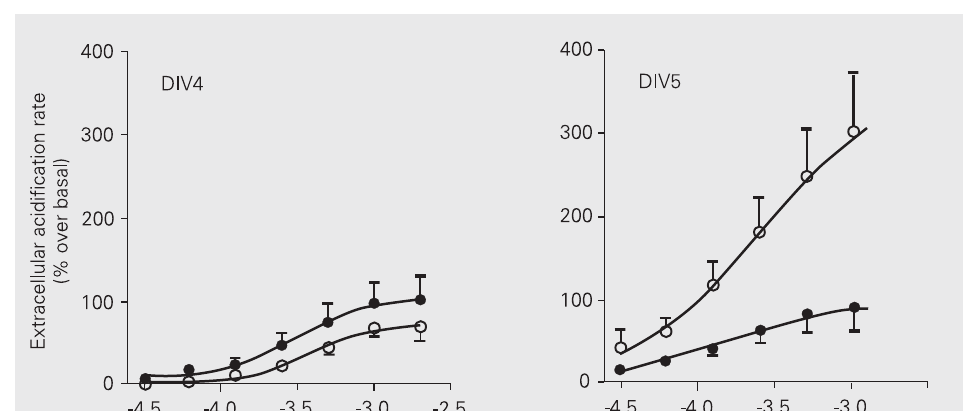
Figure 3. Dihydro-ß-erythroidine (DHßE) blocks the acetylcholine- induced increase in extracellular acidification rate of retinal cells in culture. Retinal cells cultured for 4 (DIV4, squares) or 5 (DIV5, circles) days in vitro were incu- bated in the absence or in the presence of different concen- trations of the antagonist. DHßE inhibited the effect of 250 µM acetylcholine at DIV4 (IC 50 = 16.9 µM) in a concentration-de- pendent manner but not at DIV5. C = control. Data are re- ported as means ± SEM for 3-5 independent